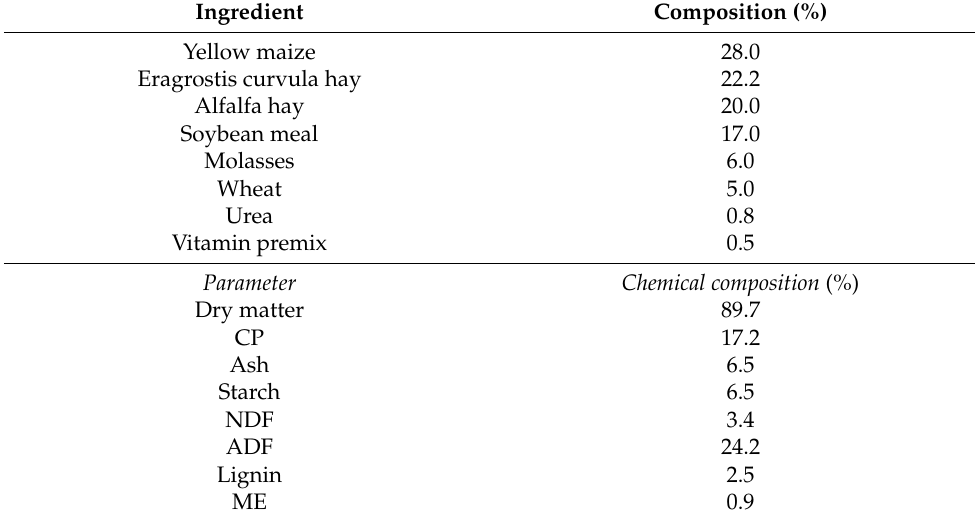
Table 1. Table 1. Formulation and chemical composition on a DM basis of the total mixed ration. Ingredient Composition (%) Yellow maize